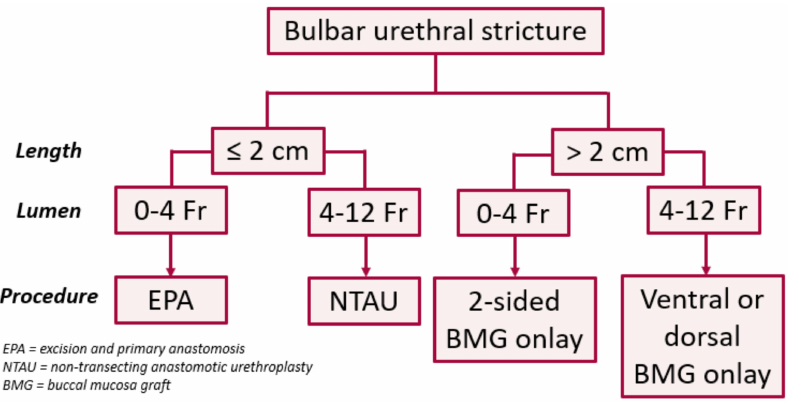
Figure 1. Treatment algorithm for bulbar